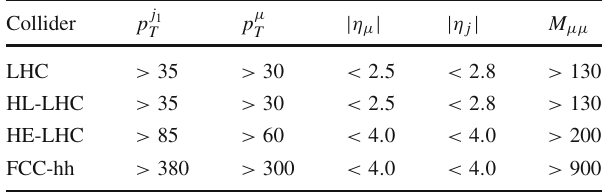
Table6 Valuesofthejetcut-offparameter xqcut inGeVusedinMLM matching of multi-jet events at the 13 TeV LHC and future colliders. All jet matching parameters are found in the presence of the